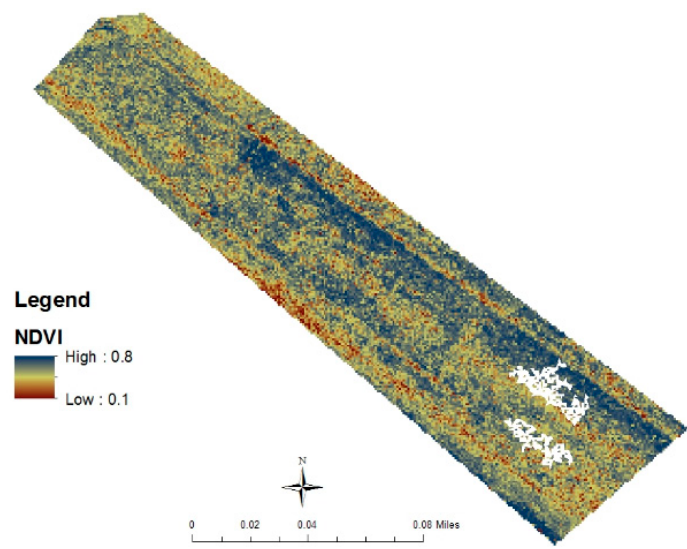
Figure 7. Pasture NDVI post-flooding.